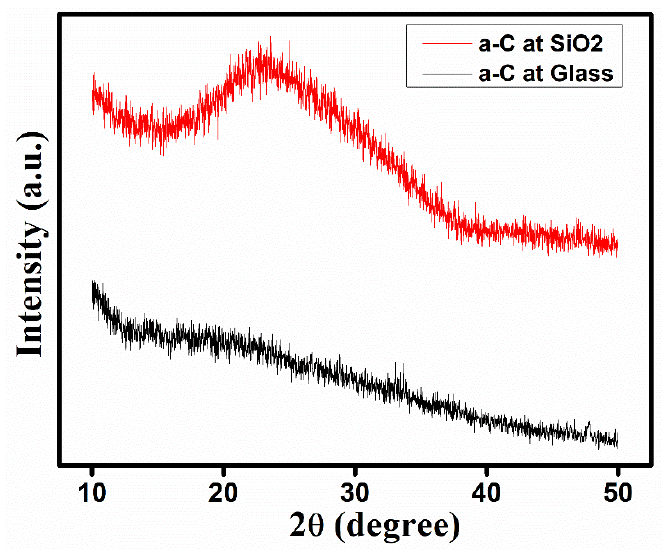
Figure 2. XRD pattern of a-Carbon sample films fabricated on glass and SiO 2 substrates.